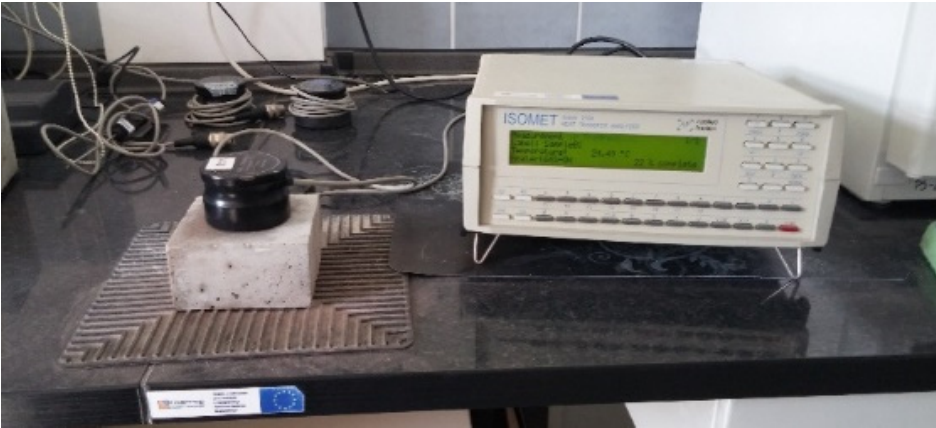
Figure 14. Thermal conductivity coefficient determined in a non-stationary method.